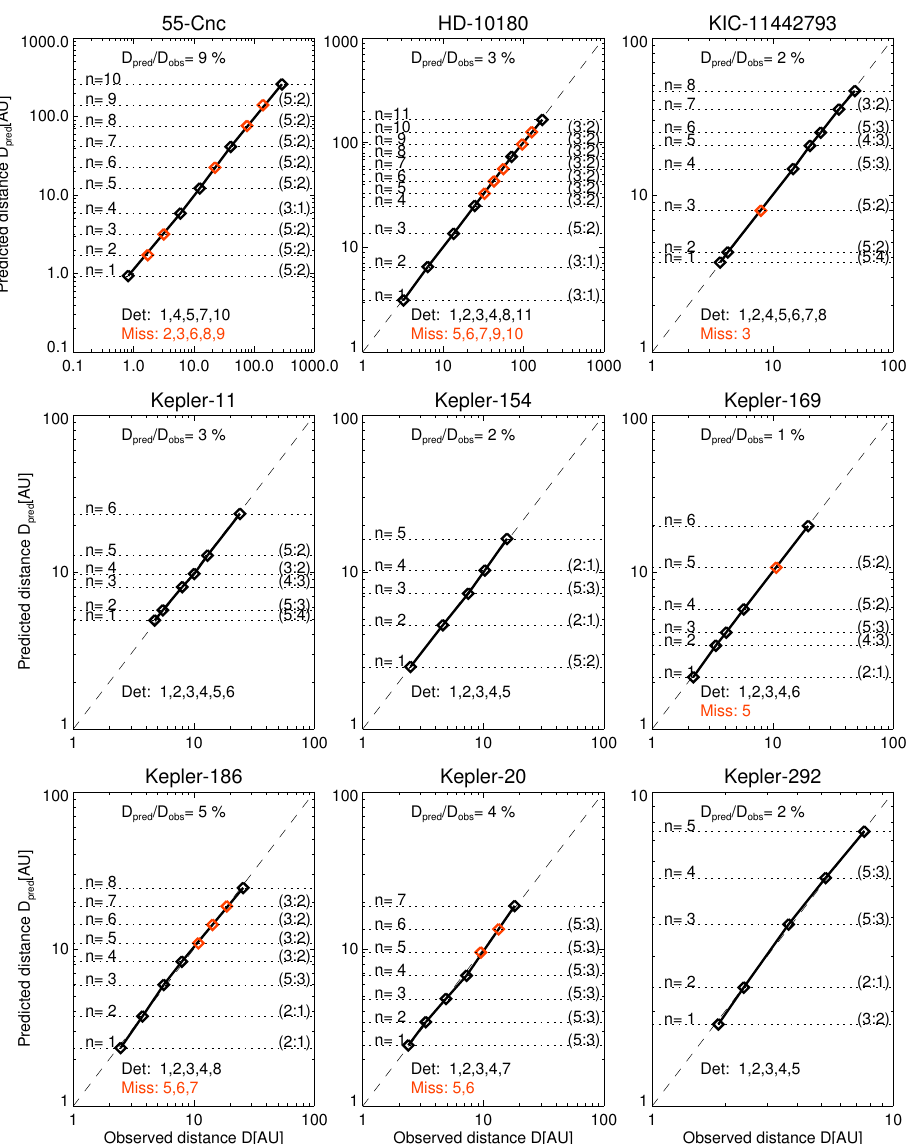
Figure 2. The predicted distances D pred versus the observed distances D obs of exoplanets from their central star in large exoplanet systems (with five, six or seven members). The detected exoplanets are marked with black diamonds and the predicted exoplanets with red diamonds. The numeration corresponds to the complete systems that include the predicted exoplanets. The average deviations between the predicted and observed distances, D pred / D obs , are given in percentages, the best-fit harmonic ratios are given on the right side, and the numeration of the detected and missing planets (red) are indicated near the bottom of each